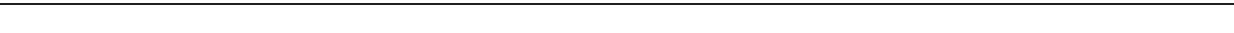
Fig. 1 Inhibition of PFKFB3 cooperates with cisplatin to promote cancer cell apoptosis. a ECAR assay was performed in WT or PFKFB3 KO HeLa cells treated with or without cisplatin (10 μ M) for 12 h using a Seahorse Bioscience XFe 96 analyzer system. Data are shown as mean with s.d. of three biological replicates. KO, knockout. b Lactate secretion in the culture medium of WT or PFKFB3 KO HeLa cells treated with or without cisplatin (10 μ M) for 24 h. Data are presented as mean ± s.d. of three biological replicates, and statistical analyses were performed using two-way ANOVA with Bonferroni ’ s post- test. * P < 0.05; n.s., not signi fi cant. c Combined use of cisplatin and PKF15 ef fi ciently induced apoptosis of cancer cells. HeLa, A549 and HCT116 cells